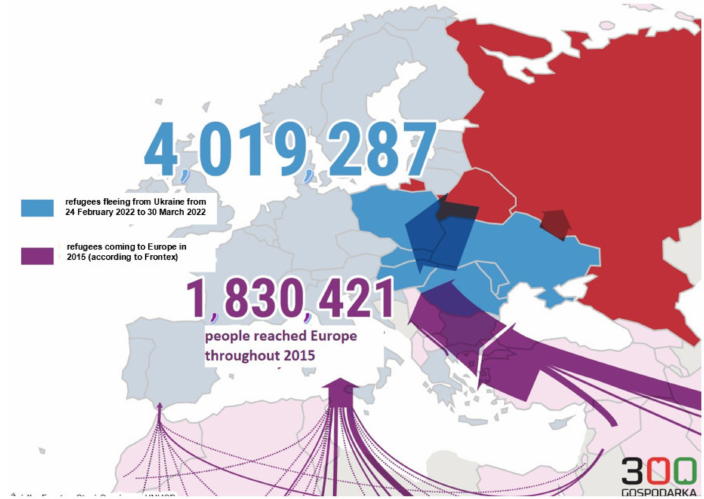
Figure 1. Refugee crises in Europe in 21st century. Source: own study based on 300gospodarka.pl (accessed on 31 March 2022) [3].